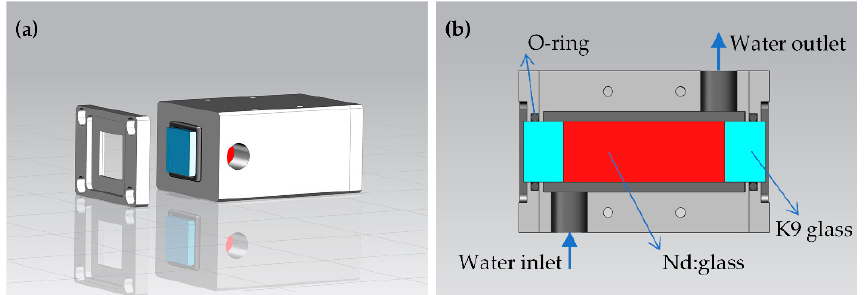
Figure 3. Amplifier head. ( a ) Structure diagram; ( b ) sectional view.